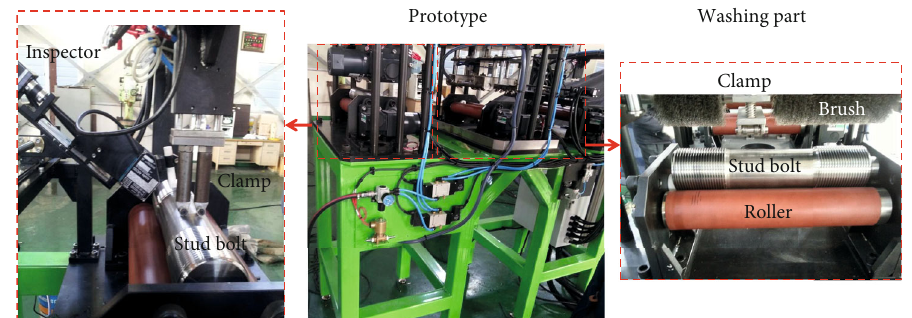
Figure 14: The prototype of the automatic equipment.